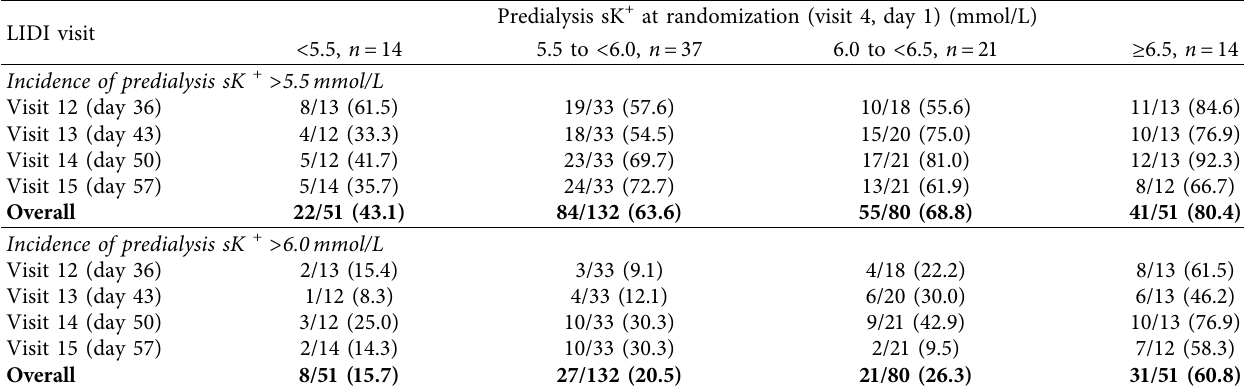
Table 2: Risk of predialysis sK + concentration > 5.5 or > 6.0mmol/L at LIDI visits during the 4-week evaluation period following the initial hyperkalemic event.